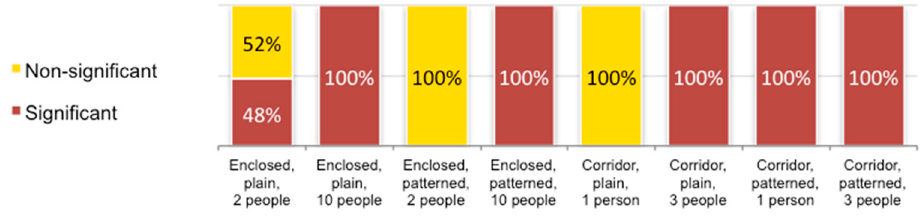
Figure 5. Percentage of participants with significant/non-significant size variations for each space in gender perception filter.